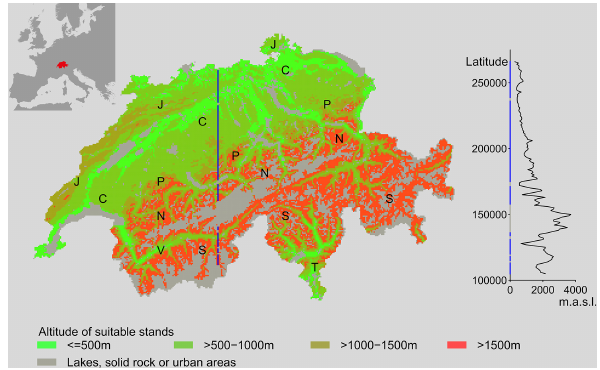
Figure 1. Location of and altitude along the analyzed transect, and location of geographic terms. The transect (blue line) is placed at a longitude of 638000m (Swiss CH1903/lv03 coordinates). J: Jura; C: Central Plateau; P: Prealps; N: north Alps; S: south Alps; V: Valais; T: